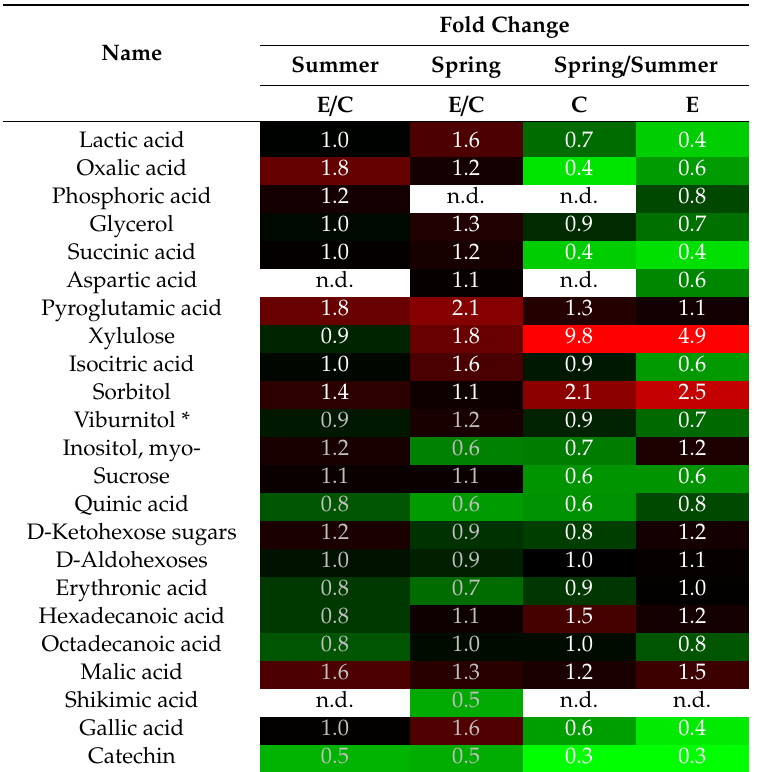
Table 5. Targeted metabolomics of the trimethylsilyl / ethoxime (TMS) derivatized organic acids and sugars from leaf extracts of Quercus pubescens . * According to the NIST (National Institute of Standards and Technology) database. Data of the ratios are means of five independent extractions. E, rain exclusion; C, control; n.d., no data. No change is considered for a fold change of